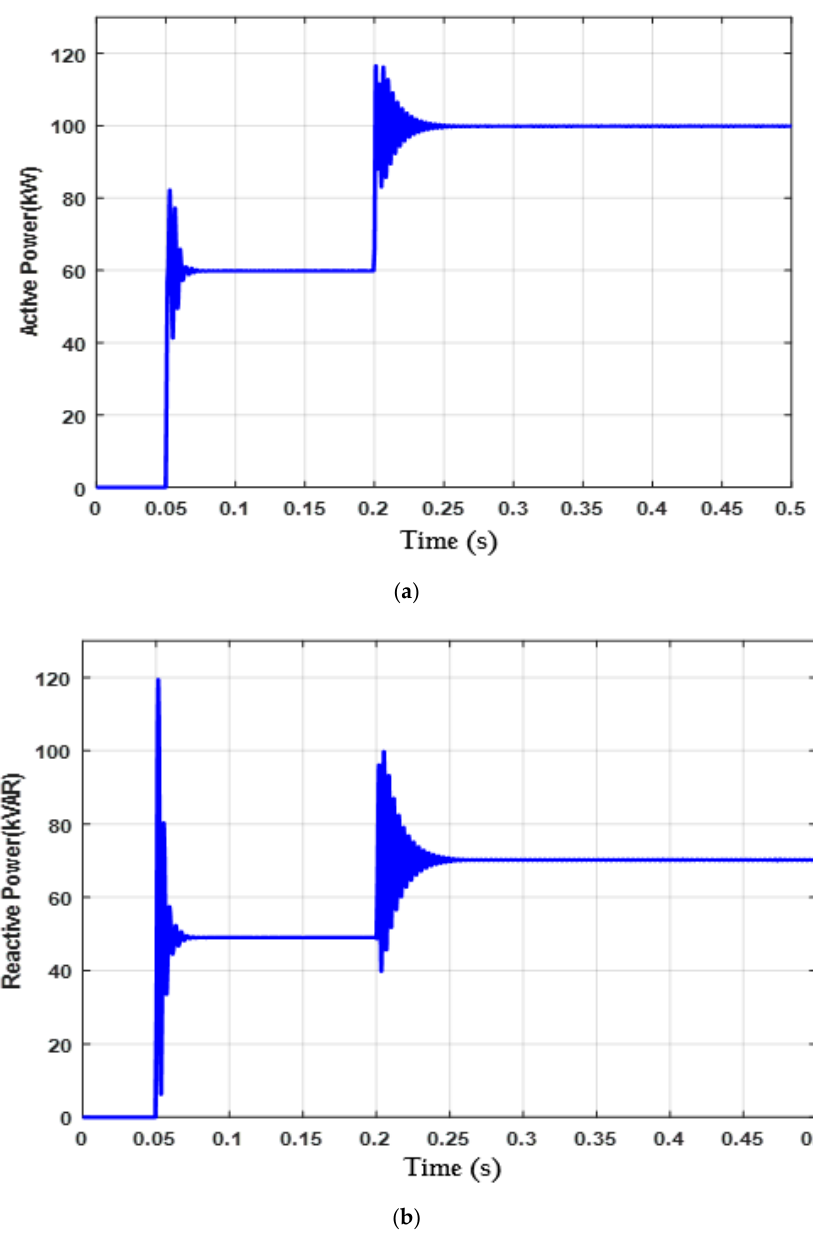
Figure 6. MG power regulation. ( a ) Active power. ( b ) Reactive power.